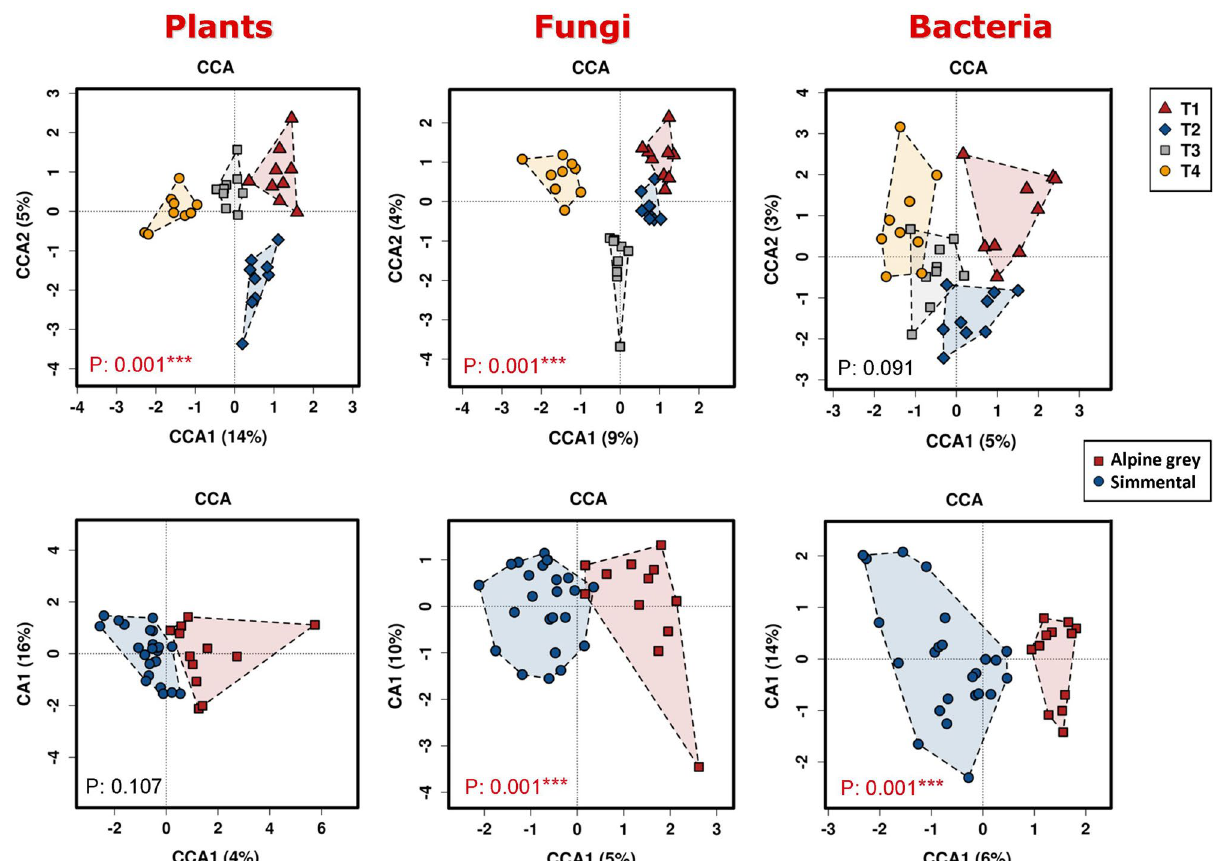
Figure 4. Canonical coordinate analysis of standardized relative abundances of plant, fungal and bacterial taxa in relation to sampling time and cow breed. The respective significance levels are indicated into the panels and highlighted in red when significant p values were